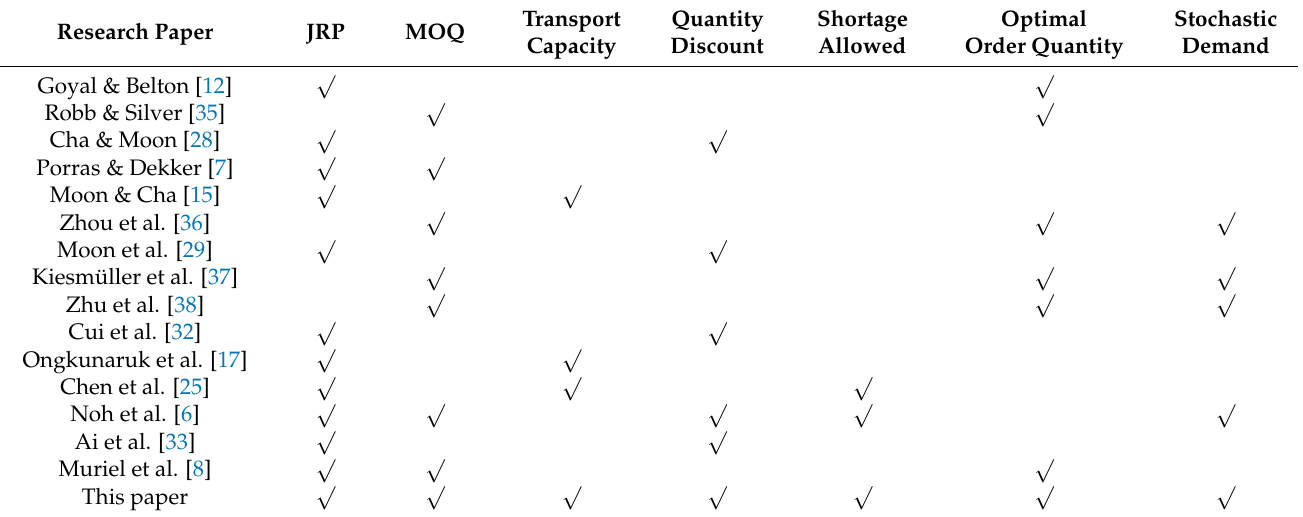
Table 1. Position of Our Work in the Existing